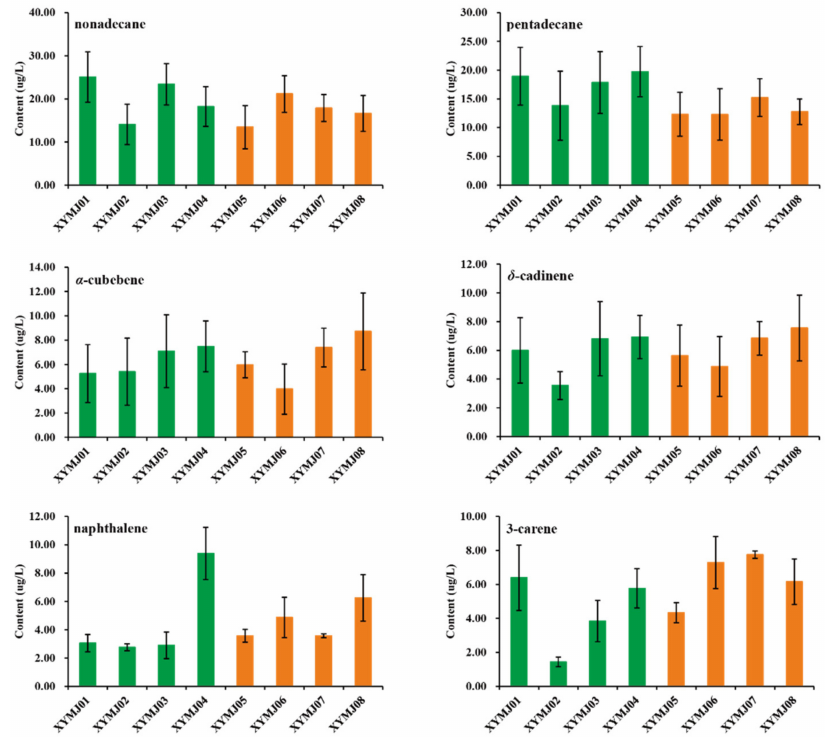
Figure 5. Various change trends of the hydrocarbons in XYMJ green teas. All data are expressed as mean ± S.D. ( n =